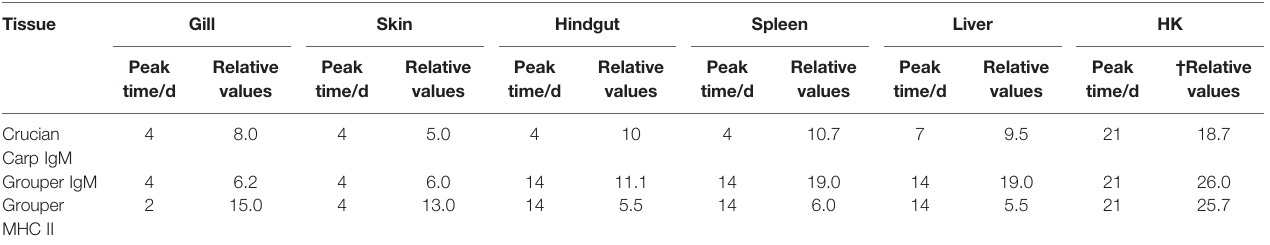
† Relative value the ratio of gene expression in the same tissues between the immunized grouper and the control group.